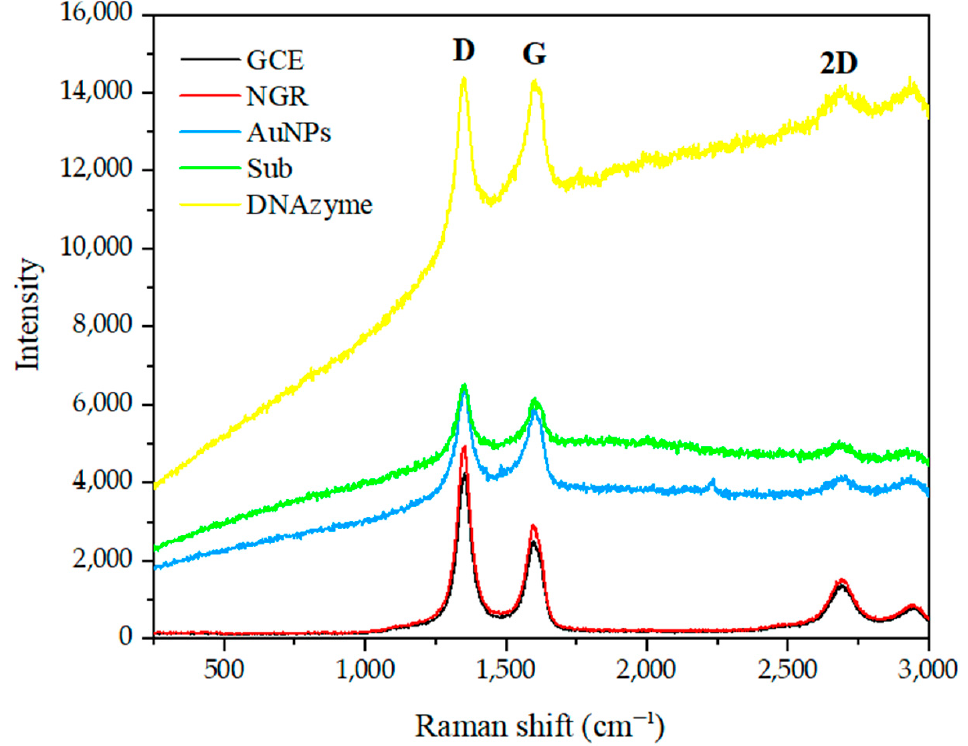
Figure 3. Raman spectrum of GCE modified with NGR, AuNPs, Sub and DNAzyme.